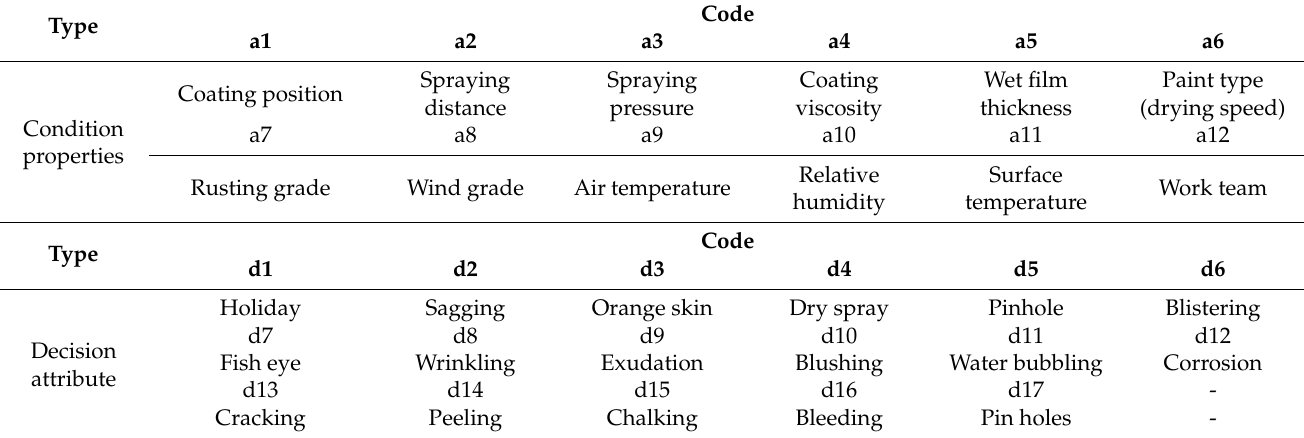
Table 4. Condition attribute and decision attribute